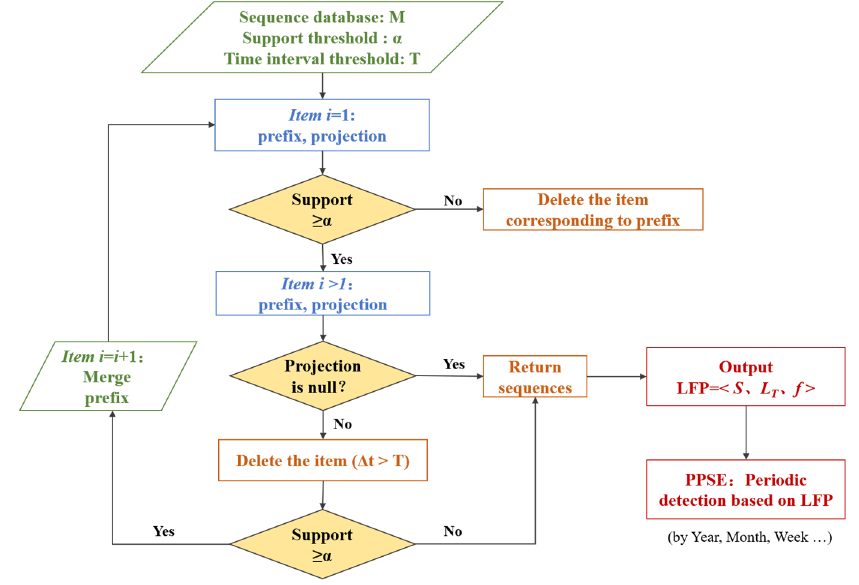
Figure 4. A flow chart showing how the PPSE works.